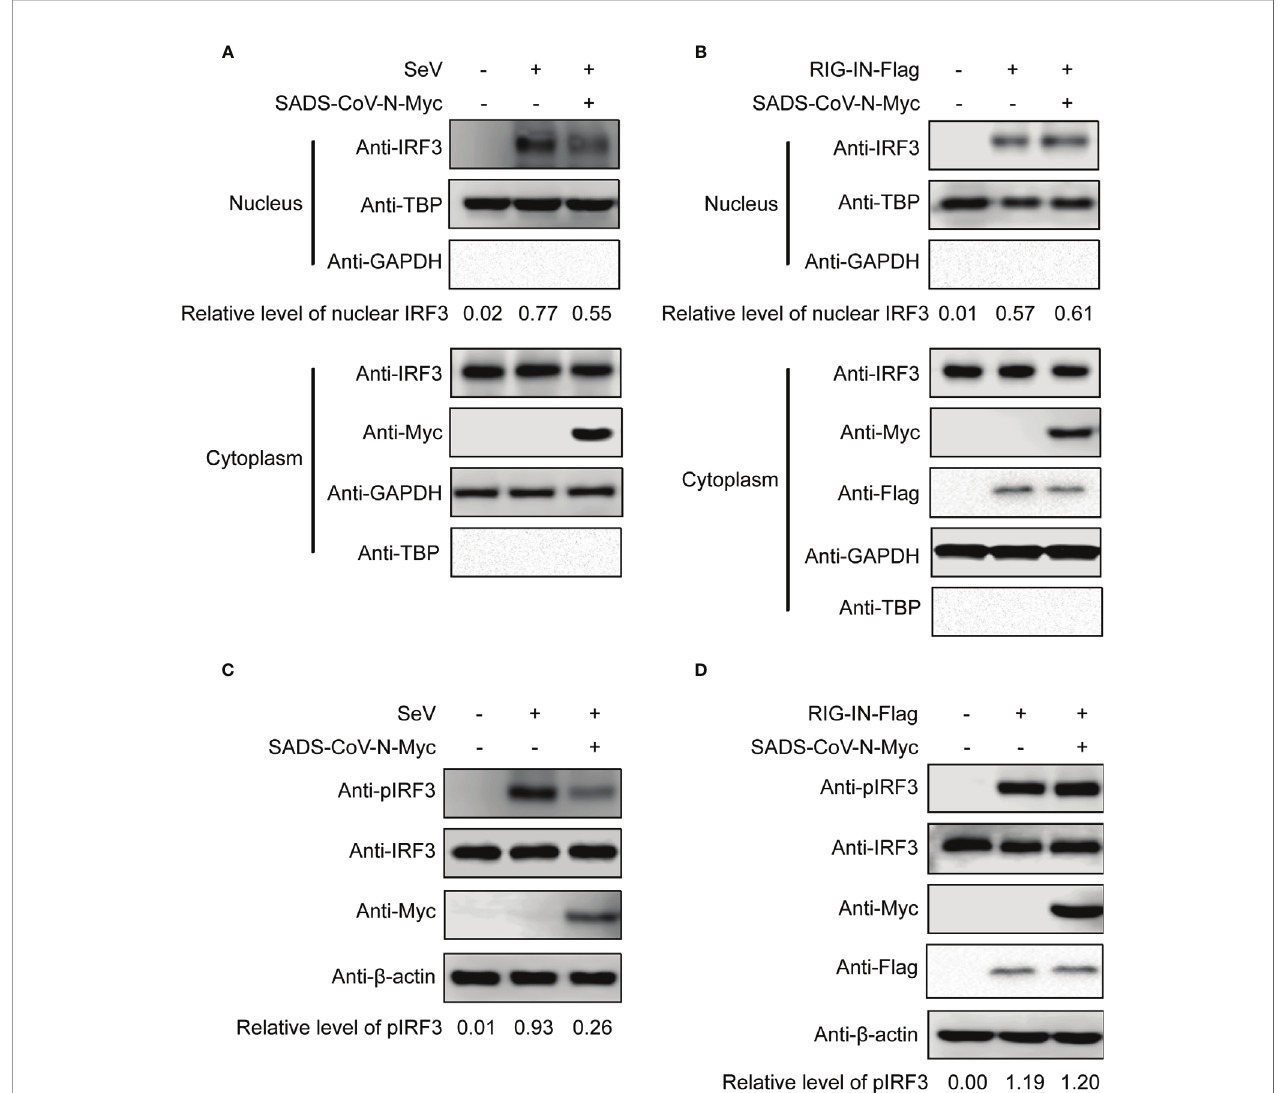
FIGURE 3 | The SADS-CoV N protein inhibits the phosphorylation and nuclear translocation of IRF3 induced by SeV. 293T cells were transfected with an expression vector carrying the SeVCoV N gene, and IRF3 was activated either by SeV infection (A, C) or RIG-IN cotransfection (B, D) . Endogenous IRF3 nuclear translocation (A, B) and phosphorylation (C, D) were detected by western blot at 36 h post-transfection in nuclear and cytoplasmic fractions. GAPDH, TBP and b - actin were used as loading controls in cytoplasm, nucleus and whole cell lysates, respectively. Quanti fi cation of each band intensity was done using Image Lab software